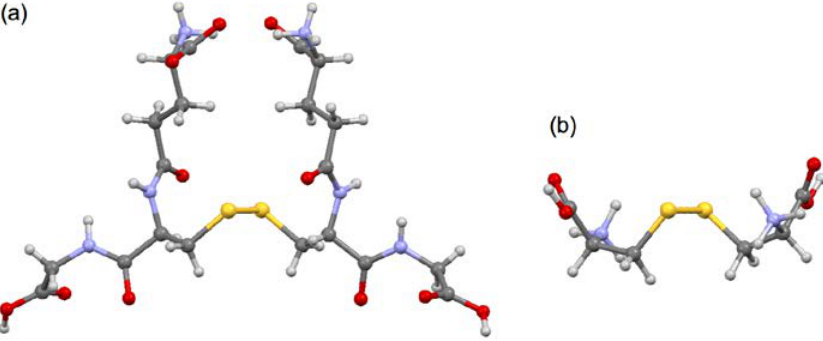
Figure 1. Structures of 1 (E = E’ = S) ( a ) and di-protonated form of 4 (E = E’ = S) ( b ), determined by X-ray analysis.